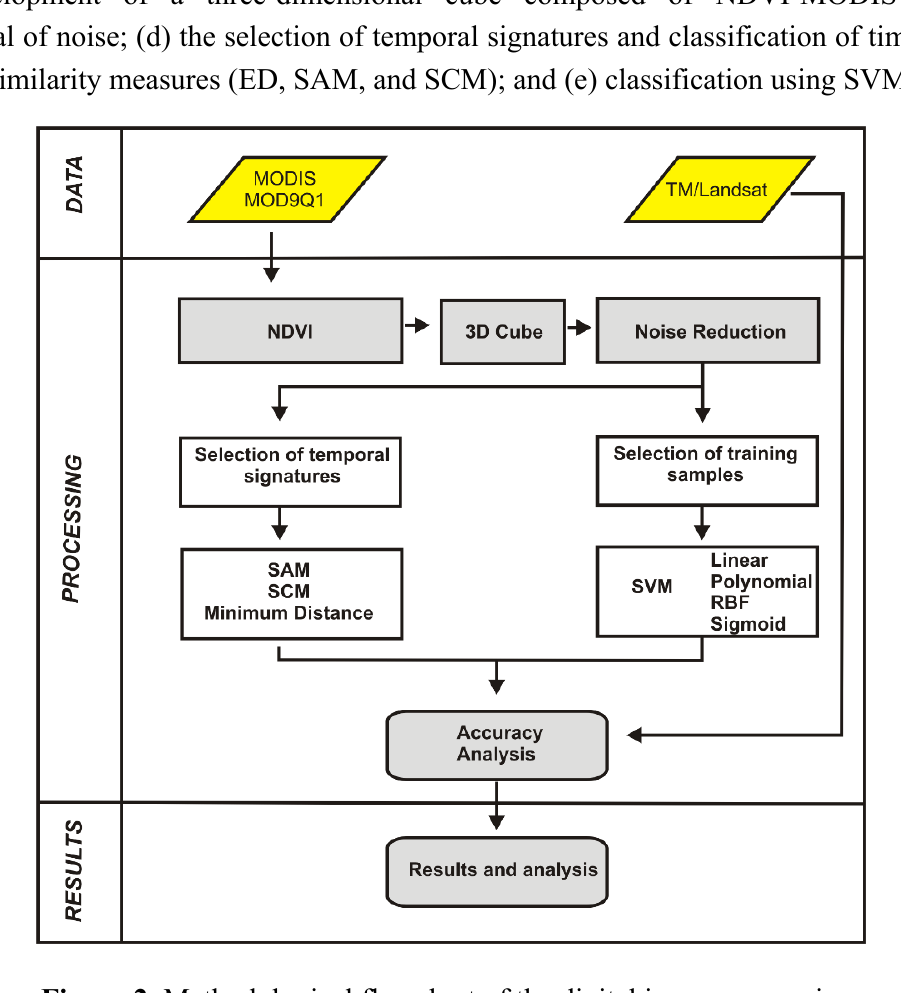
Figure 2. Methodological flowchart of the digital image